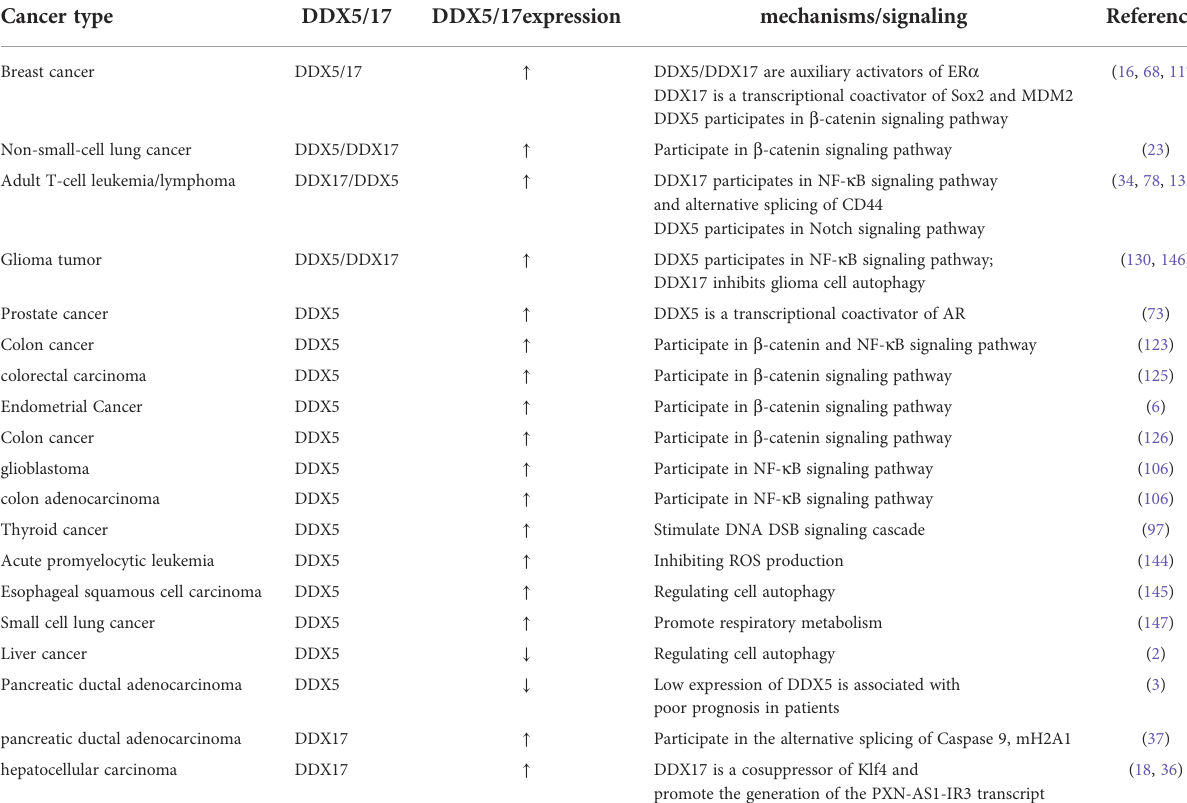
TABLE 4 Expression and mechanism of DDX5/17 in different